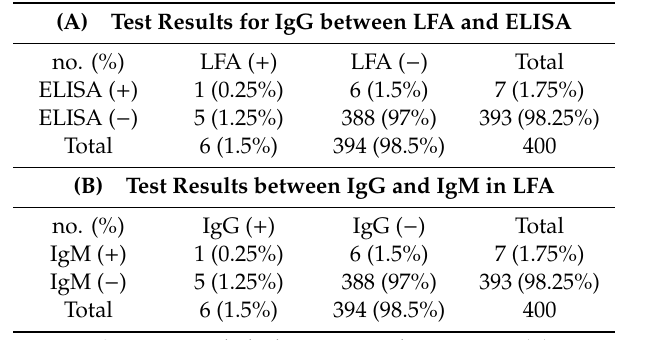
Table 1. Comparison of anti-SARS-CoV-2-NP IgG and IgM assay specificities in LFA and ELISA in Pre-COVID-19 sera.